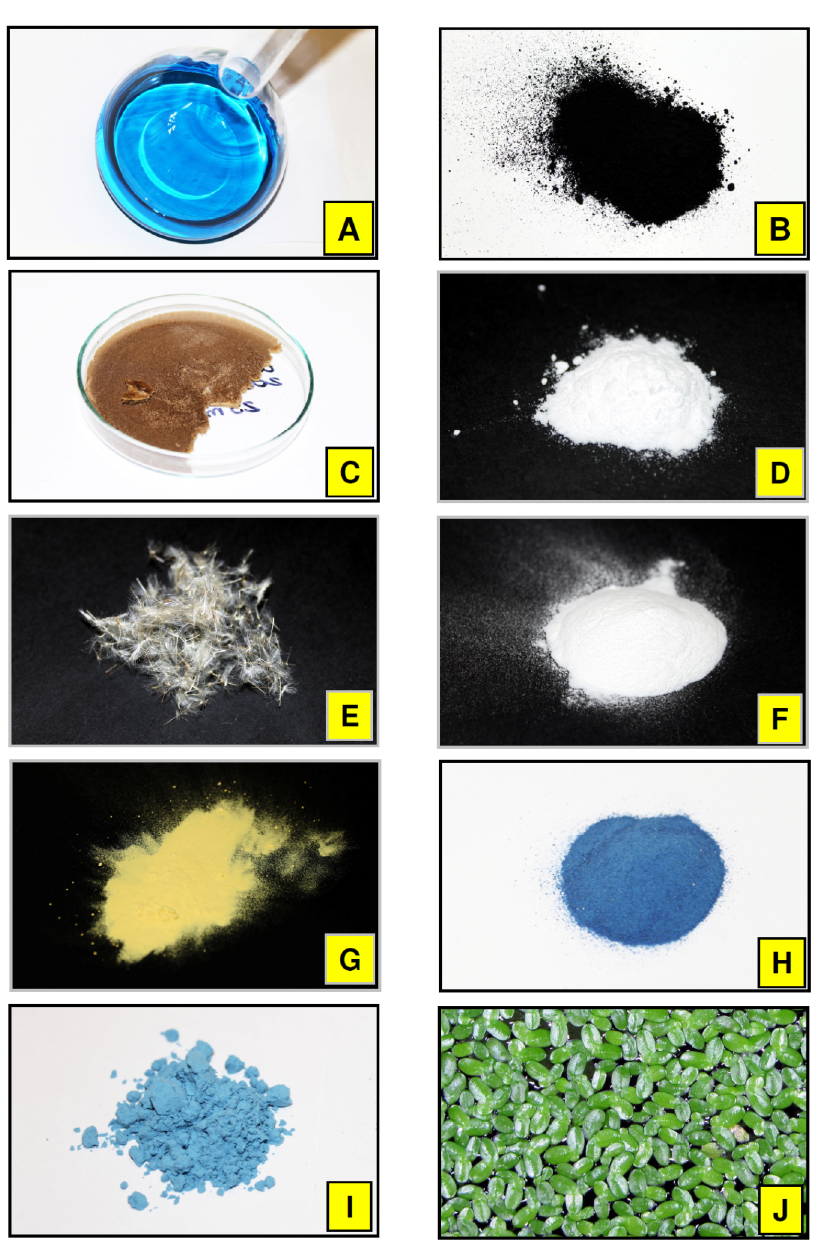
Figure 3. General view of target chemical stock solution (Brilliant Blue 5 mgxmL −1 ;( A ) and additives studied: active carbon ( B ), lyophilized graphene oxide ( C ), β-cyclodextrin ( D ), raw dandelion pappus without seeds ( E ), microcrystalline cellulose ( F ), raw pine pollen ( G ), Egyptian Blue (synthesis 1 EB1-( H ); synthesis 2 EB2-( I ), and duckweed water plant ( J ).